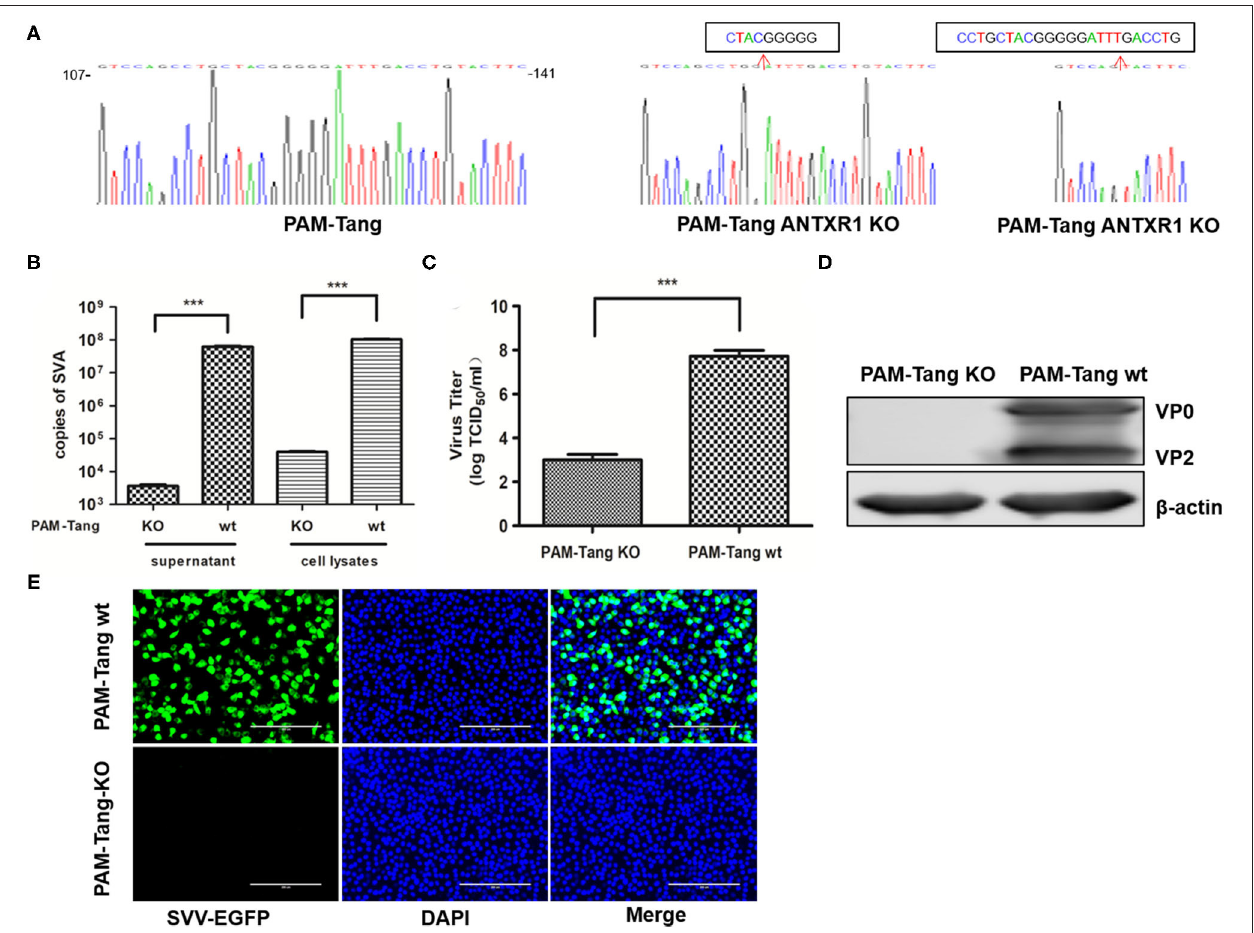
FIGURE 3 | pANTXR1 knockdown suppressed SVA replication in PAM-Tang cells. (A) The genomic sequences around the target sites of WT and PAM-Tang ANTXR1 KO cells. (B) The qPCR analysis of SVA copy numbers in supernatant and cell lysates (*** p < 0.001). (C) The TCID 50 assay for SVA titers (*** p < 0.001). (D) The Western blot assay for the expression of SVA VP2 and VP0 proteins. (E) The EGFP (in green) expression level in the PAM-Tang ANTXR1 KO cells and wild type cells. Bars, 200 µ